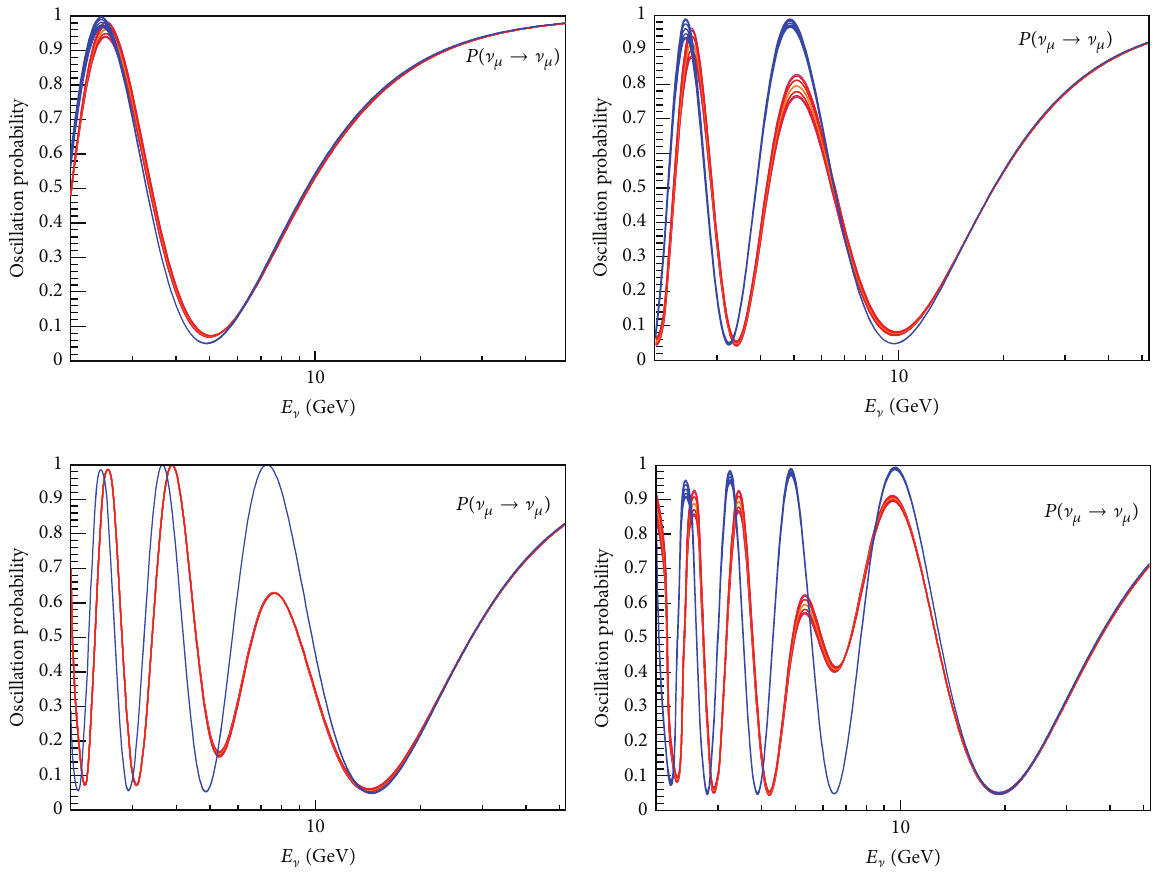
Figure 6: Neutrino oscillation probabilities 𝑃( ] 𝜇 → ] 𝜇 ) as a function of neutrino energy for different zenith angles cos Θ = 0.2 , 0.4, 0.6, and 0.8 which correspond to baselines of 2548; 5097; 7645; 10194km. Oscillation parameters from a global fit are used. The group of red lines is varied in steps of 30 ∘ between 0 ∘ and 330 ∘ for NH, blue for IH, and 𝜙 CP